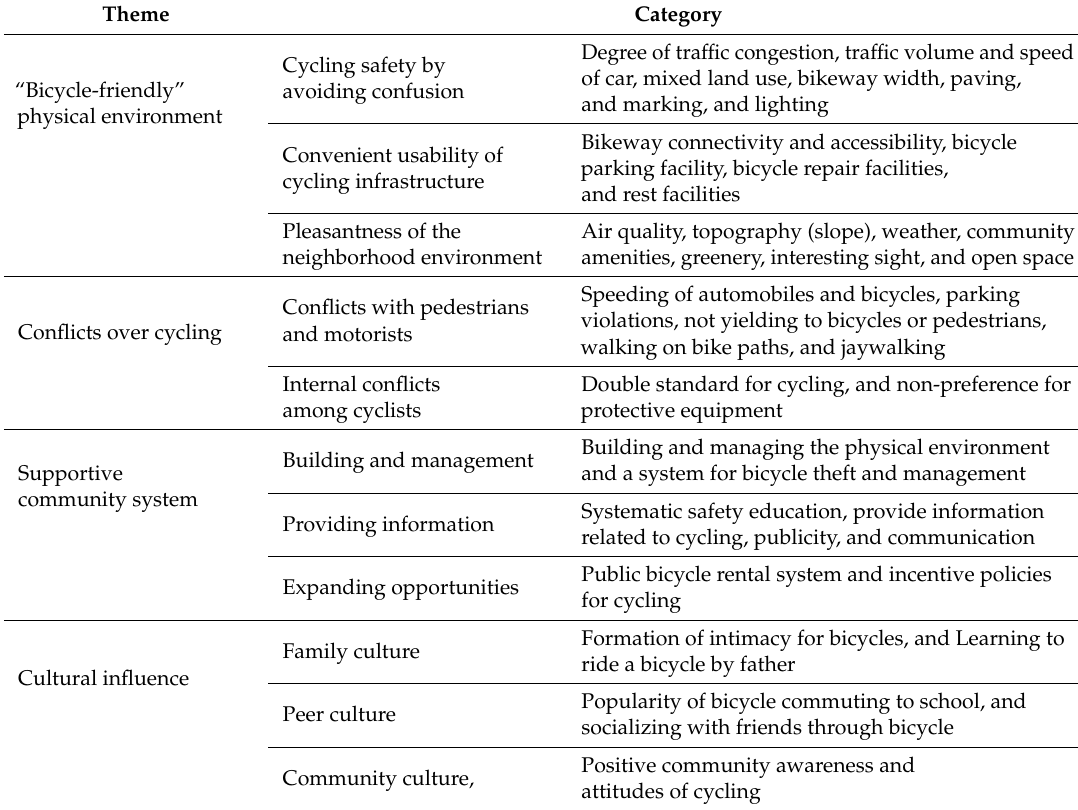
Table 2. Themes and categories of perceived